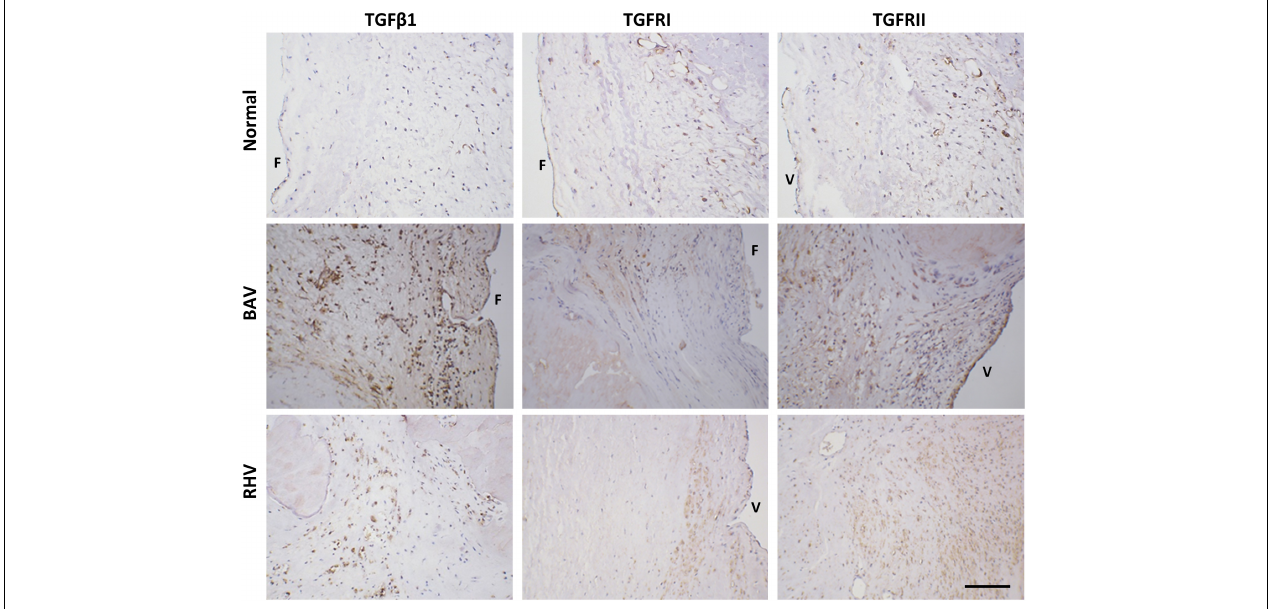
FIGURE 7 | The expression of transforming growth factor β 1 (TGF β 1), TGFR1, and TGFRII in normal, BAV and RHV cusps. F and V represent the fibrosal and ventricularis side, respectively. Scale bar is 200 µ m.